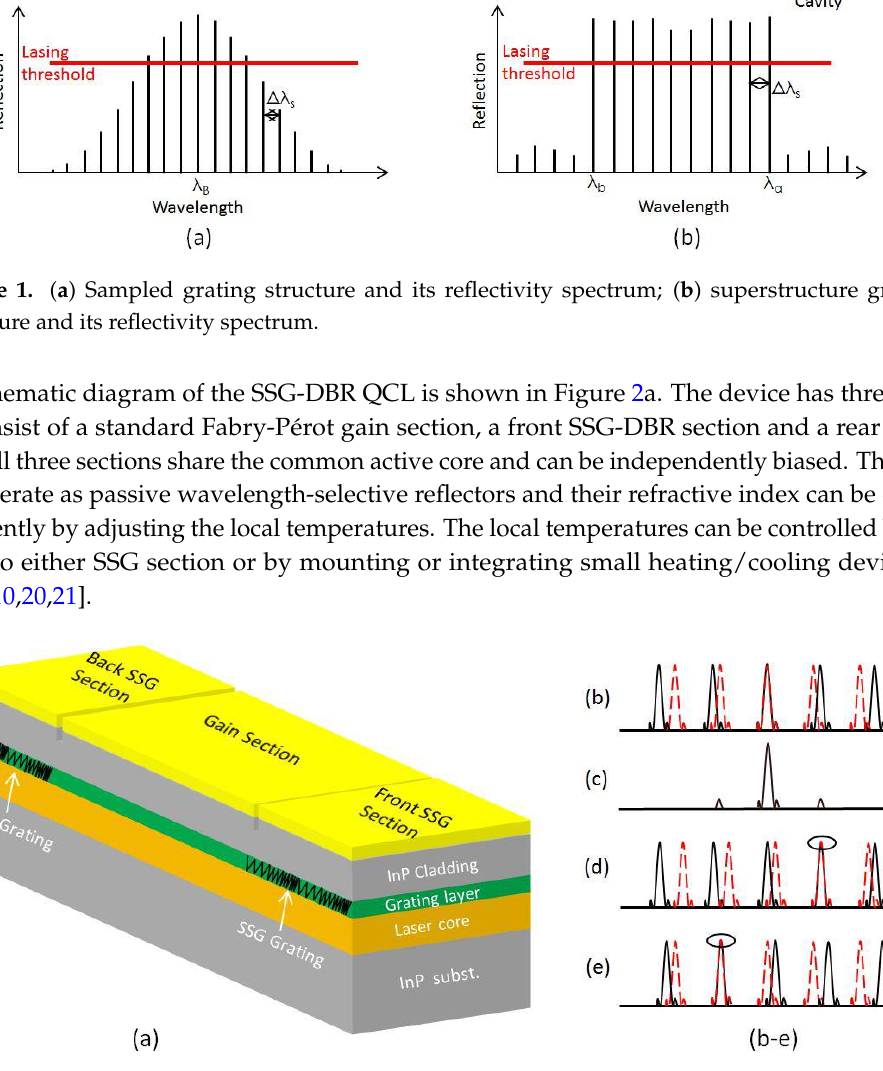
Figure 2. ( a ) Schematic of a three-section widely tunable SSG-DBR laser, consisting of two SSG reflectors with slightly different superperiods on each side of a Fabry-Perot (FP) cavity; ( b – e ) The reflection spectra of the SSGs for different current injection schemes. The reflectivities of the two SSGs are depicted as frequency combs (front SSG as black solid line, rear SSG as red dots line) with slightly different mode spacings.